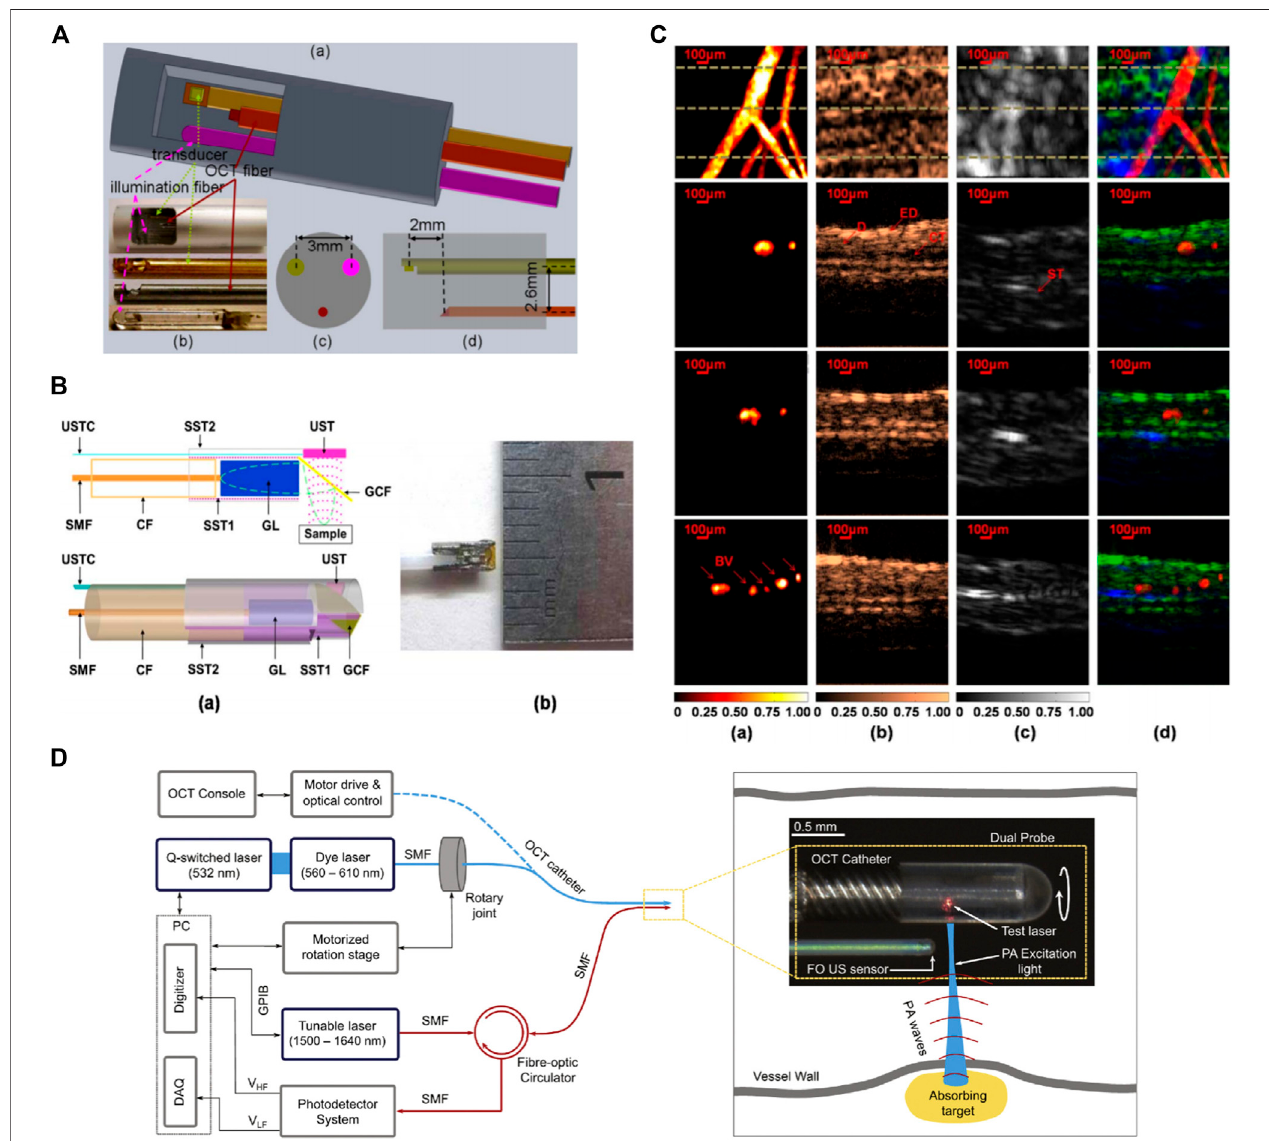
FIGURE 10 | (A) Integrated OCT-US-PAI three-modality endoscopic probe. Reprinted with permission from [158]. (B) Schematic and photograph of miniature integratedprobe.Reprintedwithpermissionfrom[160]. (C) Invivo imagesofaratear.Maximumamplitudeprojectionimages(toprow)andcross-sectionalimages(2nd, 3rd, and bottom rows) corresponding to the dotted lines in fi rst row images. (a) OR-PAM, (b) OCT, (c) US, and (d) fused images. Reprinted with permission from [160]. (D) Schematic of the dual-modality PA-OCT system. An enlarged image of the distal end of the probe. Reprinted with permission from